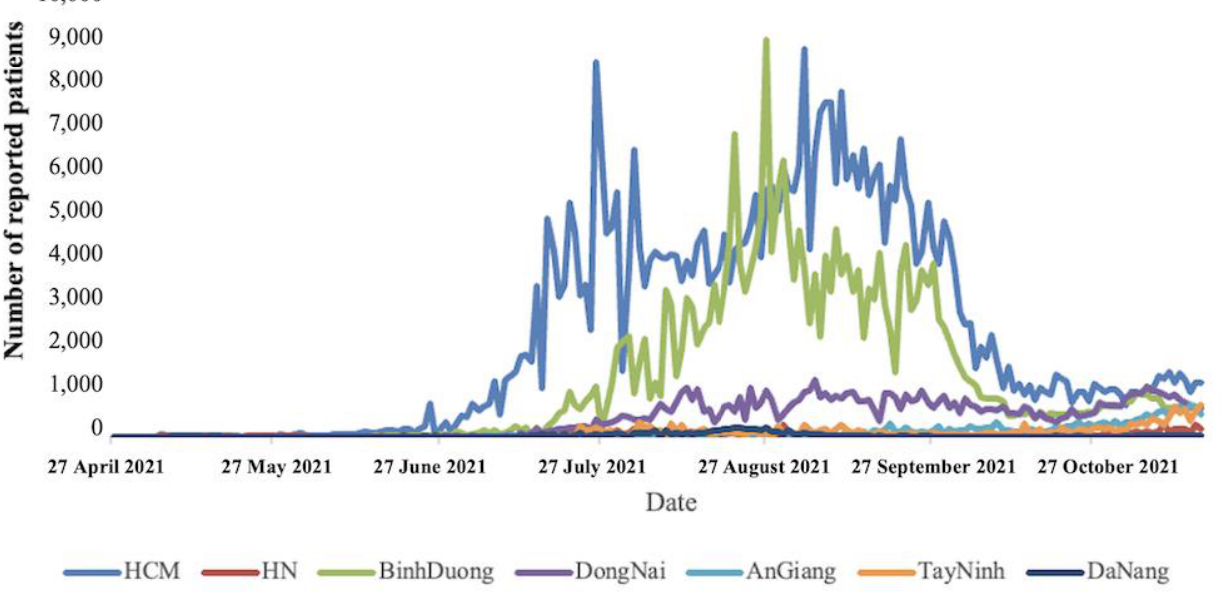
Figure 3. The total number of daily reported cases from 27 April to 16 November 2021 in some significantly affected provinces by COVID-19 in the fourth